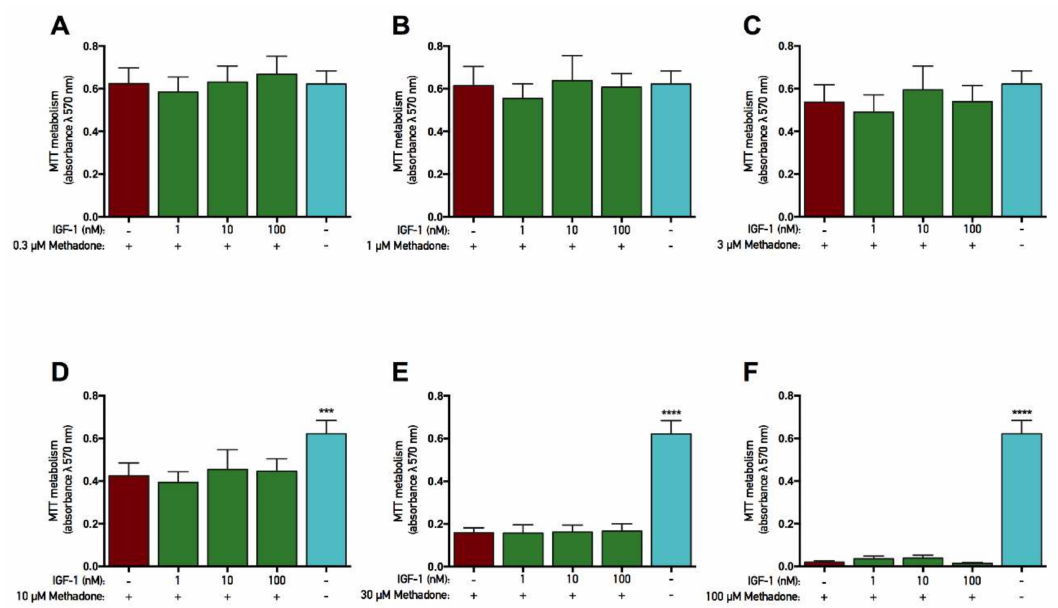
Figure 5. No protective effects of insulin-like growth factor-1 on mitochondrial function were found when co-treated with methadone. Mitochondrial function was assessed by tetrazolium bromide (MTT) assay. Insulin-like growth factor-1 (IGF-1) was added with methadone for three consecutive days prior to analysis. (A) Effects of 0.3 µ M methadone with or without 1–100 nM IGF-1. There were no differences between groups. (B) Effects of 1 µ M methadone with or without 1–100 nM IGF-1. There were no differences between groups. (C) Effects of 3 µ M methadone with or without 1–100 nM IGF-1. No significant effects were observed. (D) Effects of 10 µ M methadone with or without 1–100 nM IGF-1. A significant decrease in mitochondrial function was observed when 10 µ M methadone was given alone. There was no significant difference in mitochondrial function when methadone was co-treated with IGF-1. (E) Effects of 30 µ M methadone with or without 1–100 nM IGF-1. A significant decrease in mitochondrial function was observed when 30 µ M methadone was given alone. There was no significant difference in mitochondrial function when methadone was co-treated with IGF-1. (F) Effects of 100 µ M methadone with or without 1–100 nM IGF-1. A significant decrease in mitochondrial function was observed when 100 µ M methadone was given alone. There was no significant difference in mitochondrial function when methadone was co-treated with IGF-1. Statistics were calculated using two-way analysis of variance (ANOVA) and given a significant overall effect ( p < 0.05), the data were further analyzed using Dunnet’s post hoc test and compared with results from cells treated with methadone alone. All data are presented as mean ± SEM in triplicate from three individual cultures. *** p < 0.001, **** p <